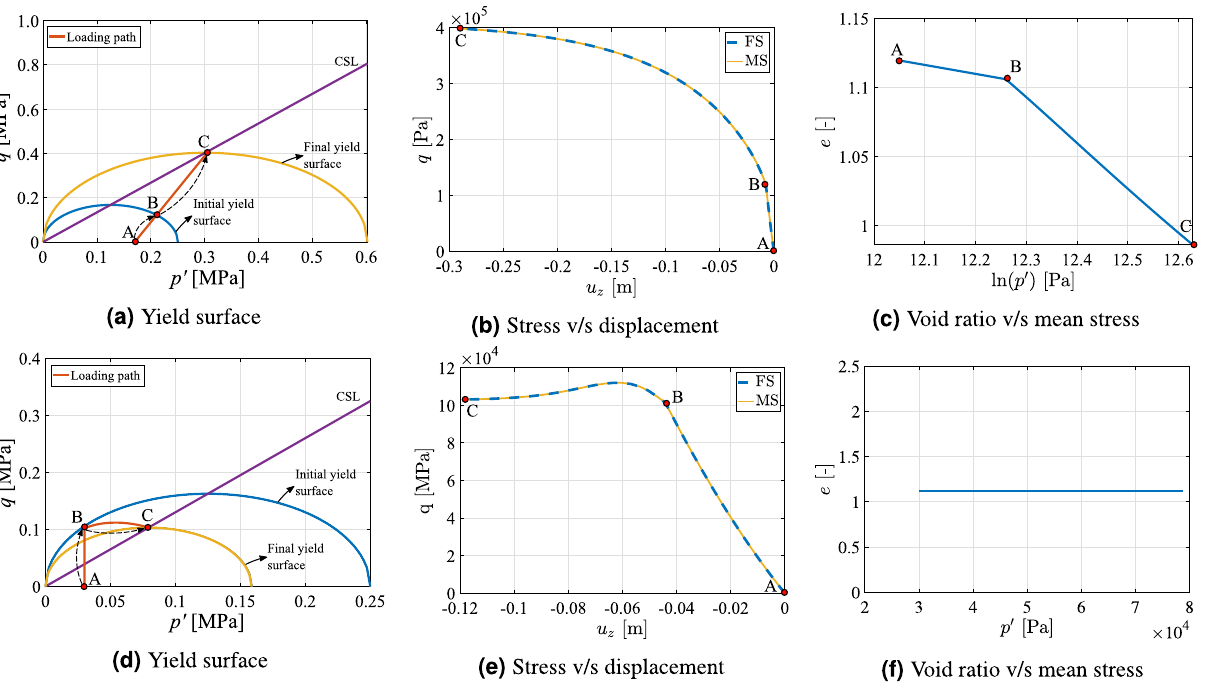
Figure 6. Comparison: illustration of the strain hardening scenario using MCC with consistency condition for drained condition (Fig. 6 a – c ) and strain softening scenario for undrained condition (Fig. 6 d – f ) respectively. Here the results are compared with FS and MS simulation methods.